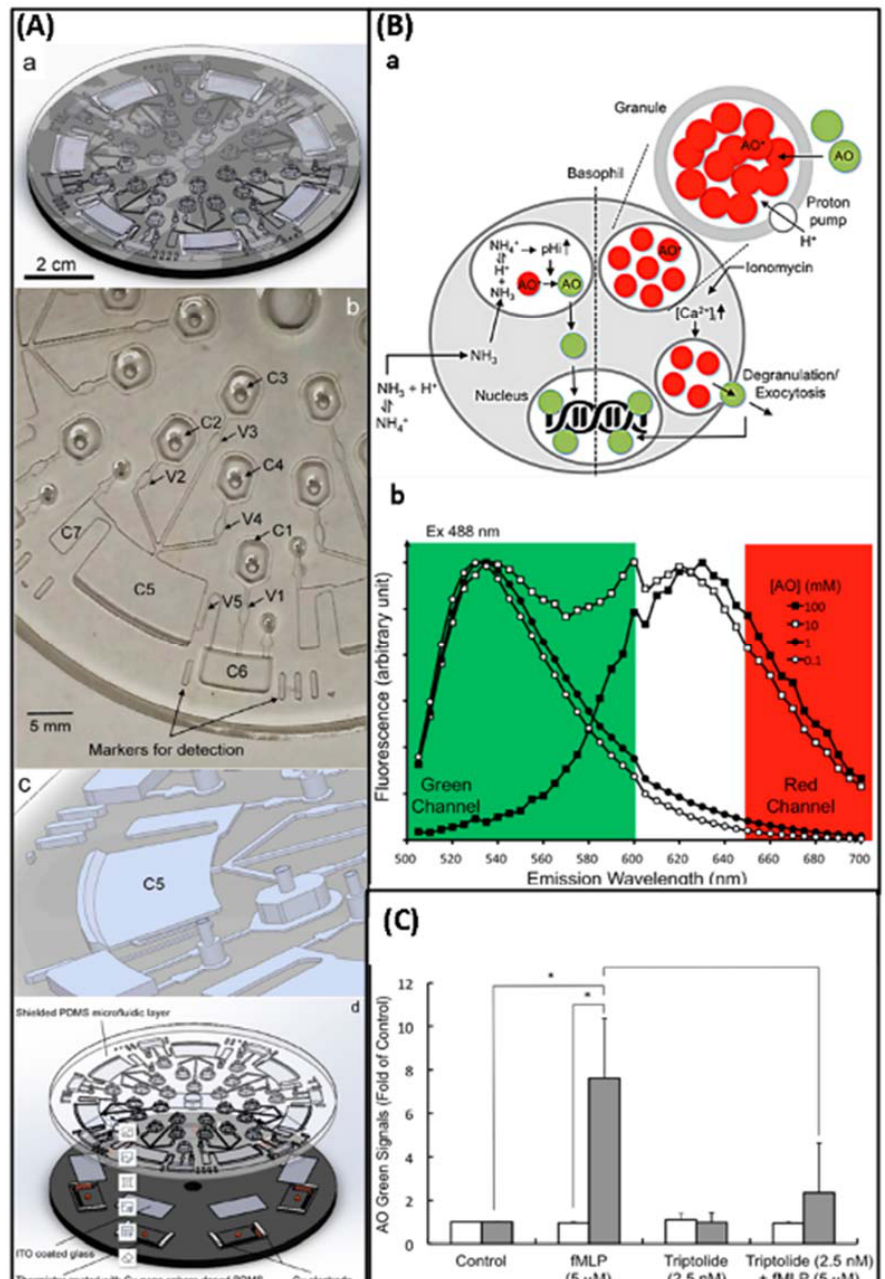
Figure 18. (Aa) Schematic diagram of the LOAD layout. (Ab) Chambers, channels, valves and siphons for testing allergenicity in one unit. (Ac) A zoom-in diagram showing the flange in C5. (Ad) Assembly of the integrated microfluidic layer. (Ba) Schematic diagram of AO as a degranulation reporter. (Bb) Red-shift phenomenon. (C) Triptolide suppressed the fMLP-mediated AO release in KU ‐ 812 cell. The image from [68], Copyright 2016, MDPI.